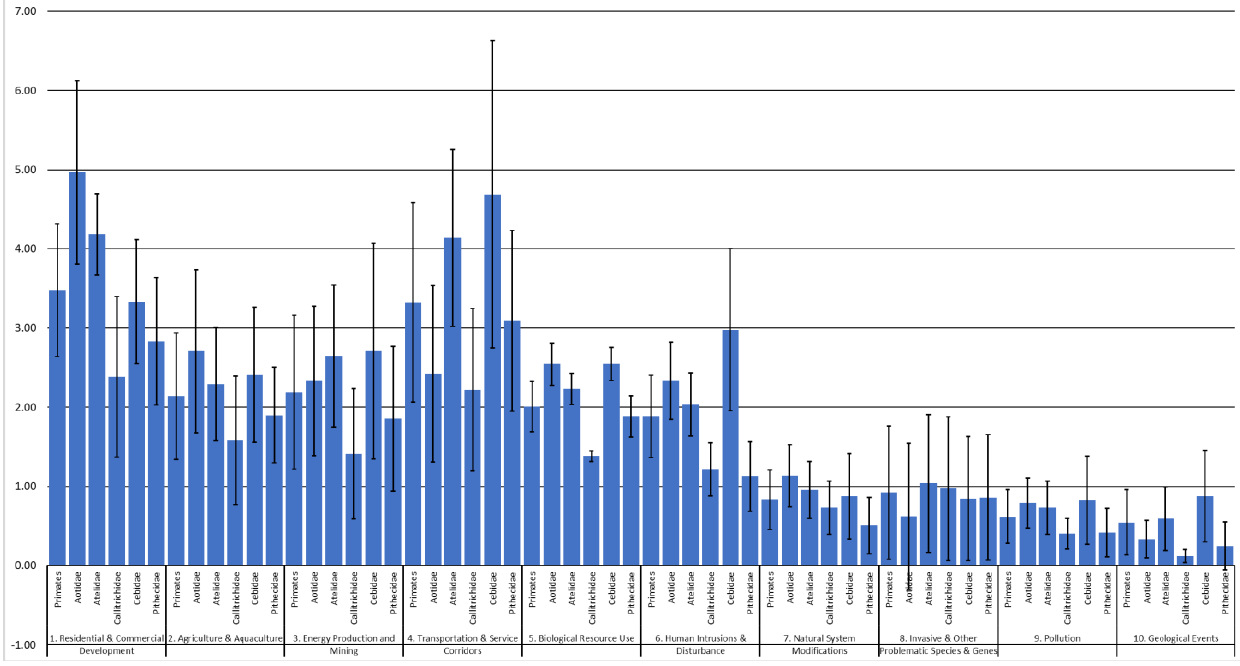
Figure 2. Predicted threat score to Peruvian primates at the family level, by major threat catego-